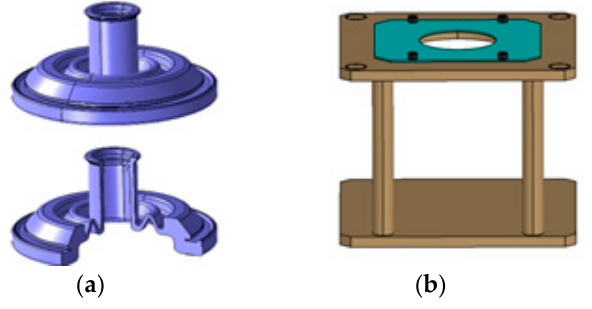
Figure 4. Grommet and jig diagram: ( a ) bellows-type grommet; ( b ) jig for fixing the panel.